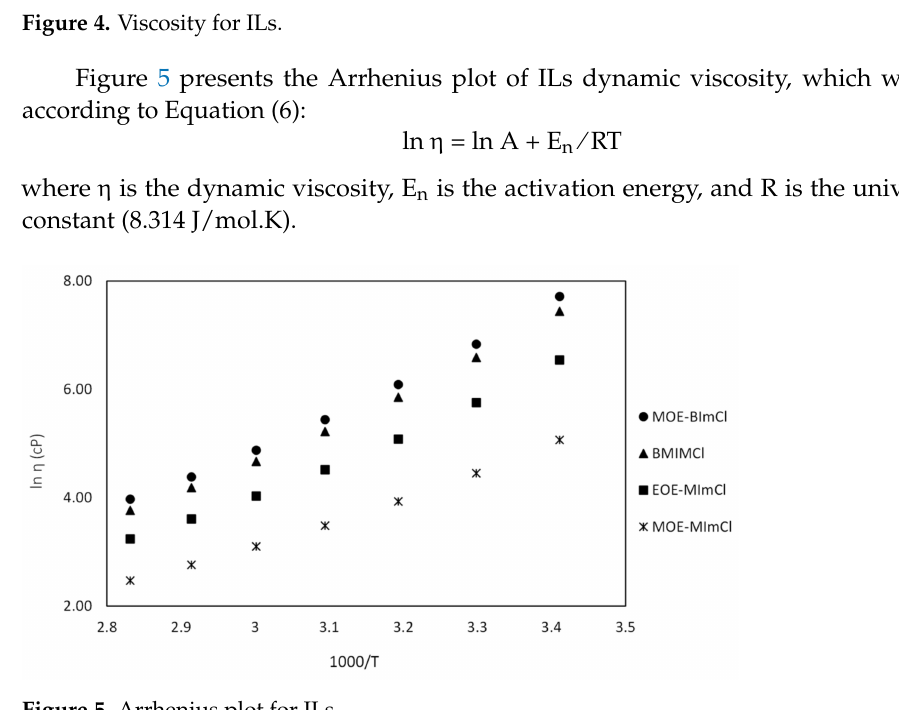
Figure 5. Arrhenius plot for